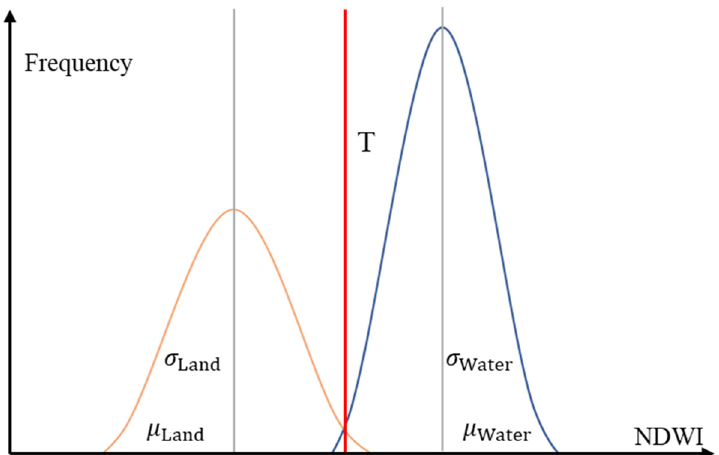
Figure 1. The diagram to illustrate the water extraction using the normalized differenced water in- dex (NDWI) and